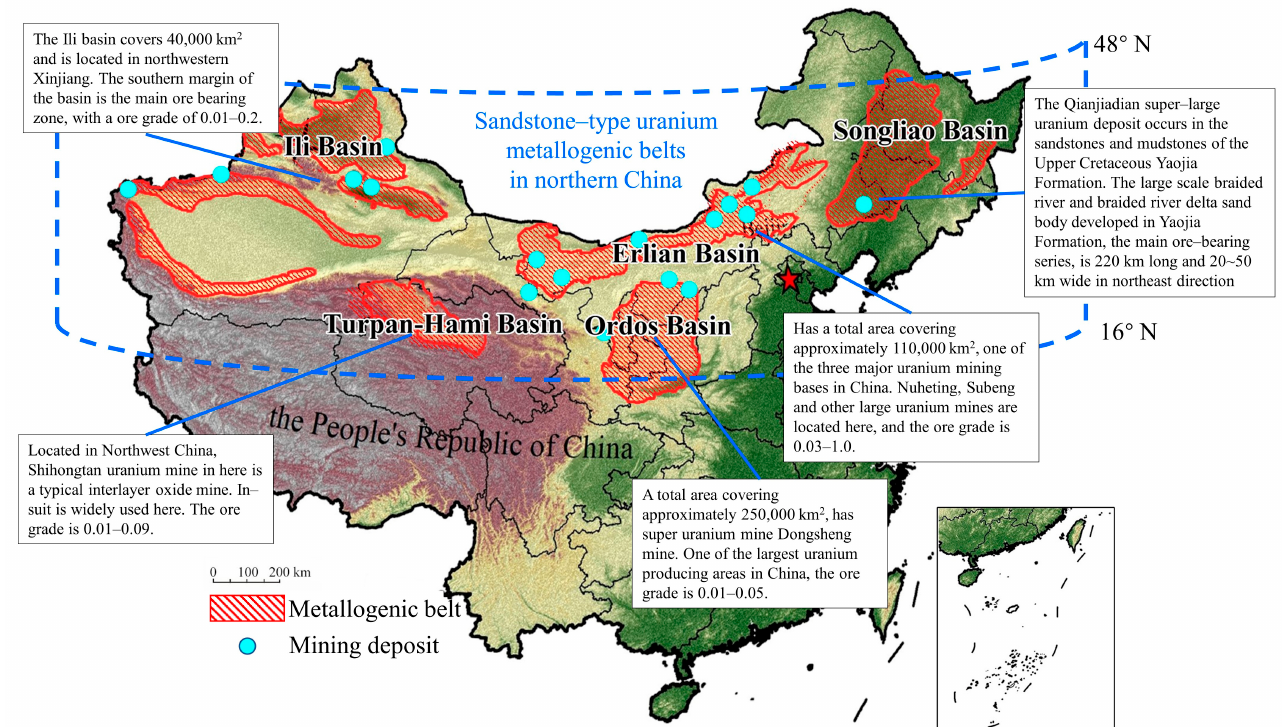
Figure 1. Distribution of sandstone-type uranium deposits in northern China.